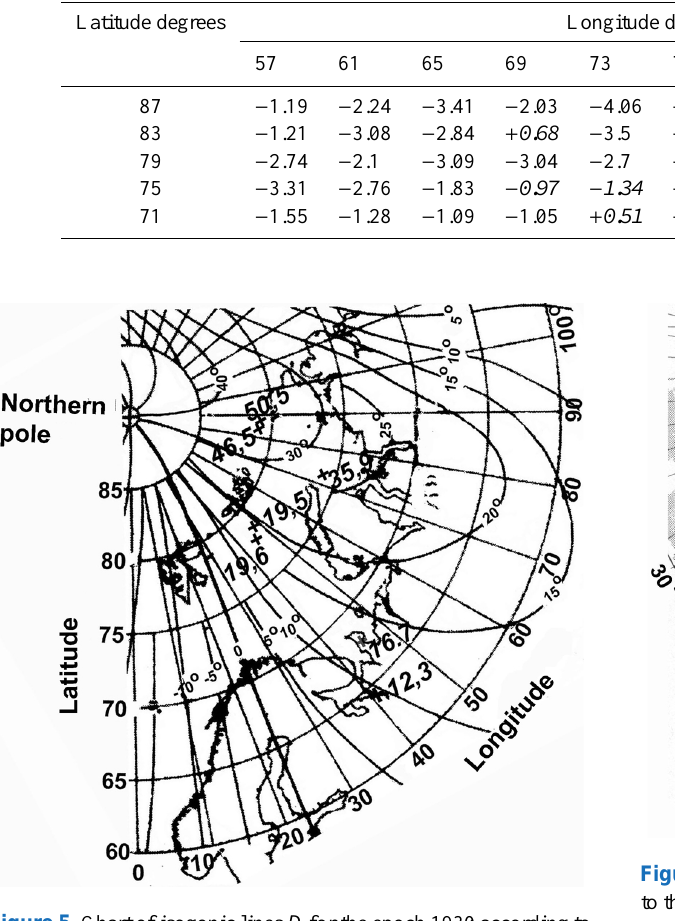
Figure 5. Chart of isogonic lines D for the epoch 1930 according to Fisk (1931) showing the points of measurements of magnetic decli- nation on board the airship.